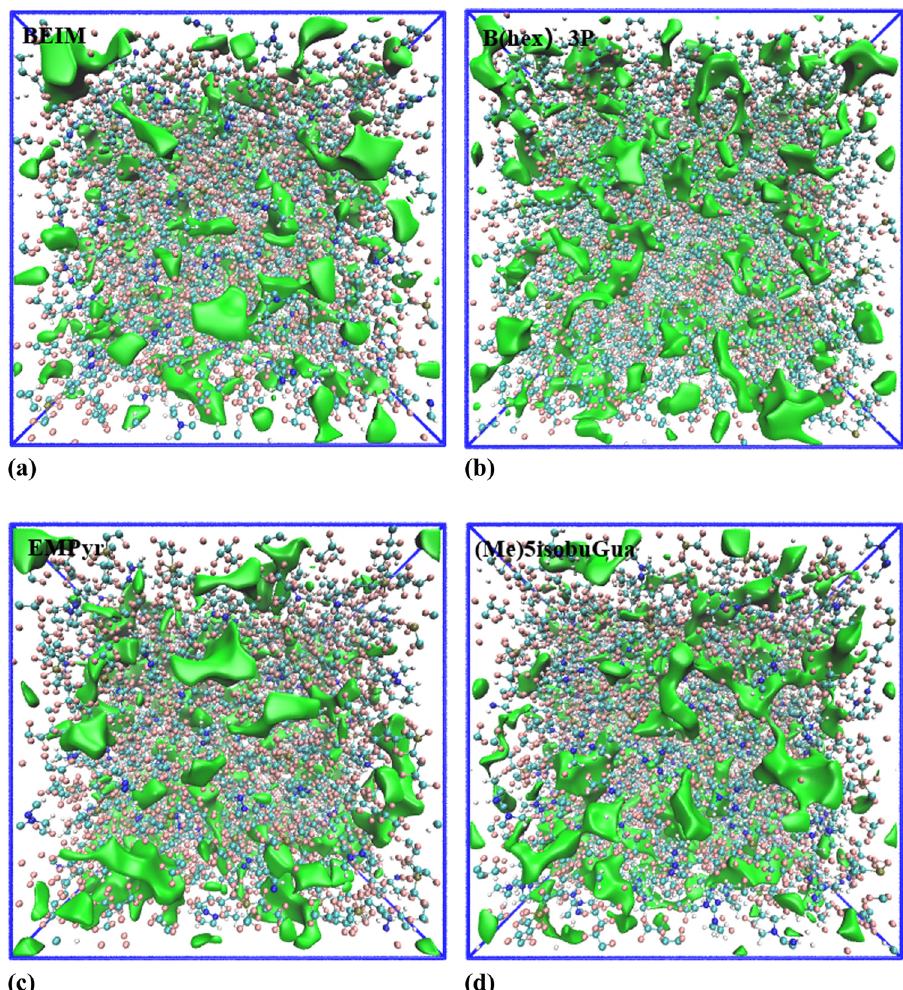
Figure 2: Representative snapshot of the FV space ( green ) within bFAP - based ILs: ( a ) [ BEIM ][ bFAP ] , ( b ) [ B ( Hex ) 3 P ][ bFAP ] , ( c ) [ EMPyr ][ bFAP ] , and ( d )[( Me ) 5 isobuGua ][ bFAP ]